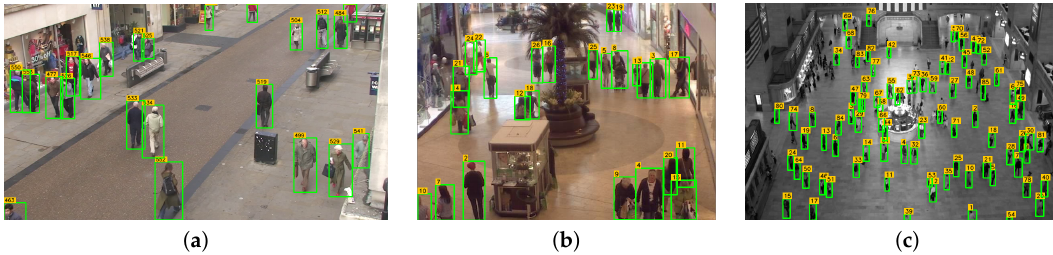
Figure 11. Detection performance of the DeepSOCIAL model in three different datasets, from a low resolution of 640 × 480 to an HD resolution of 1920 × 1080. ( a ) Oxford Town Centre [31]; ( b ) Mall Dataset [109]; ( c ) Train Station